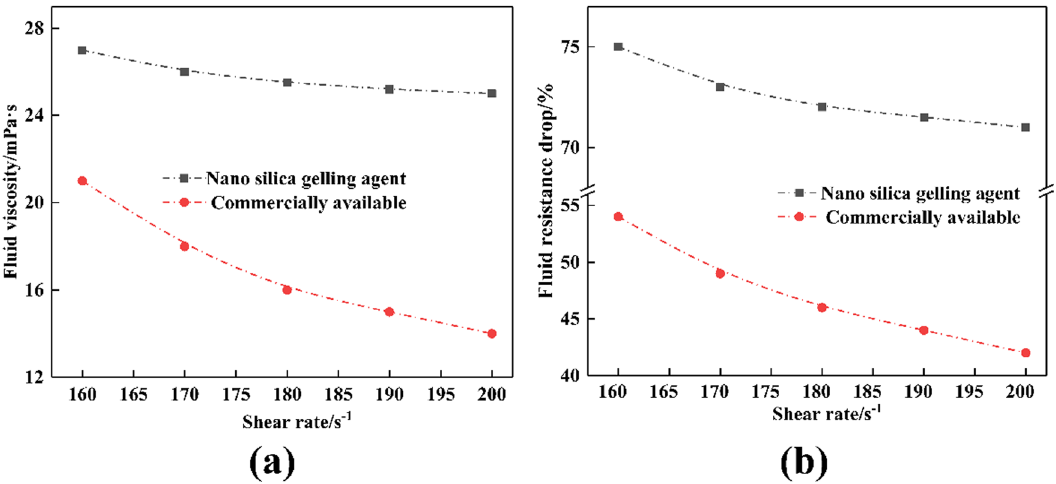
Figure 10: E ff ect of acid shear rate on apparent viscosity and friction - reducing rate: ( a ) e ff ect of shear rate on fl uid viscosity; ( b ) e ff ect of shear rate on resistance reduction